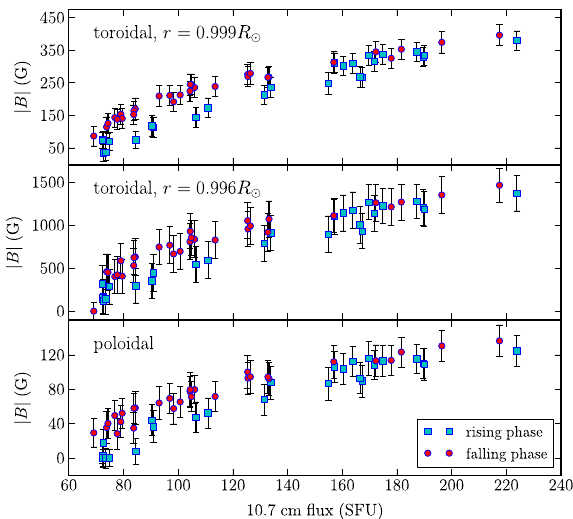
Fig.32 Thestrengthofthesolarinteriormagneticfieldduringcycle23plottedasafunctionofthe10.7-cm flux. The top two panels show the toroidal field at 0.999 R (cid:6) and 0.996 R (cid:6) . The lowest panel is the poloidal field. The cyan squares are for the rising phase of the cycle while the magenta circles are for the falling phase. Results are from Baldner et al. (2009). (Image courtesy of Charles Baldner)